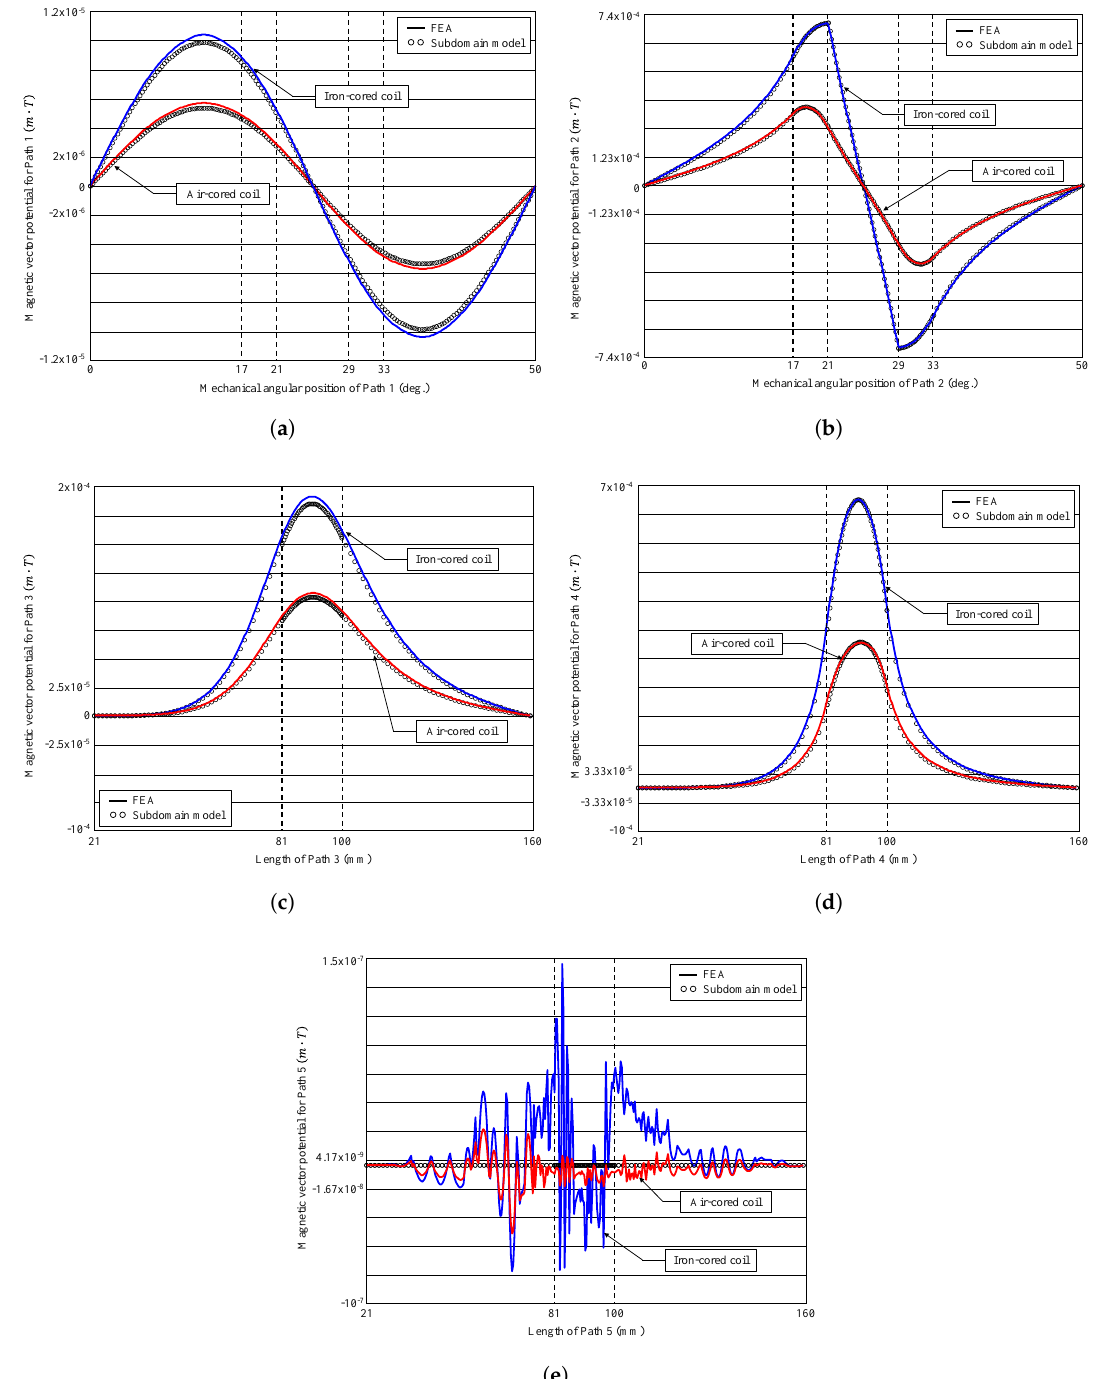
Figure 6. Waveforms of A z for: ( a ) Path 1; ( b ) Path 2; ( c ) Path 3; ( d ) Path 4; and ( e ) Path